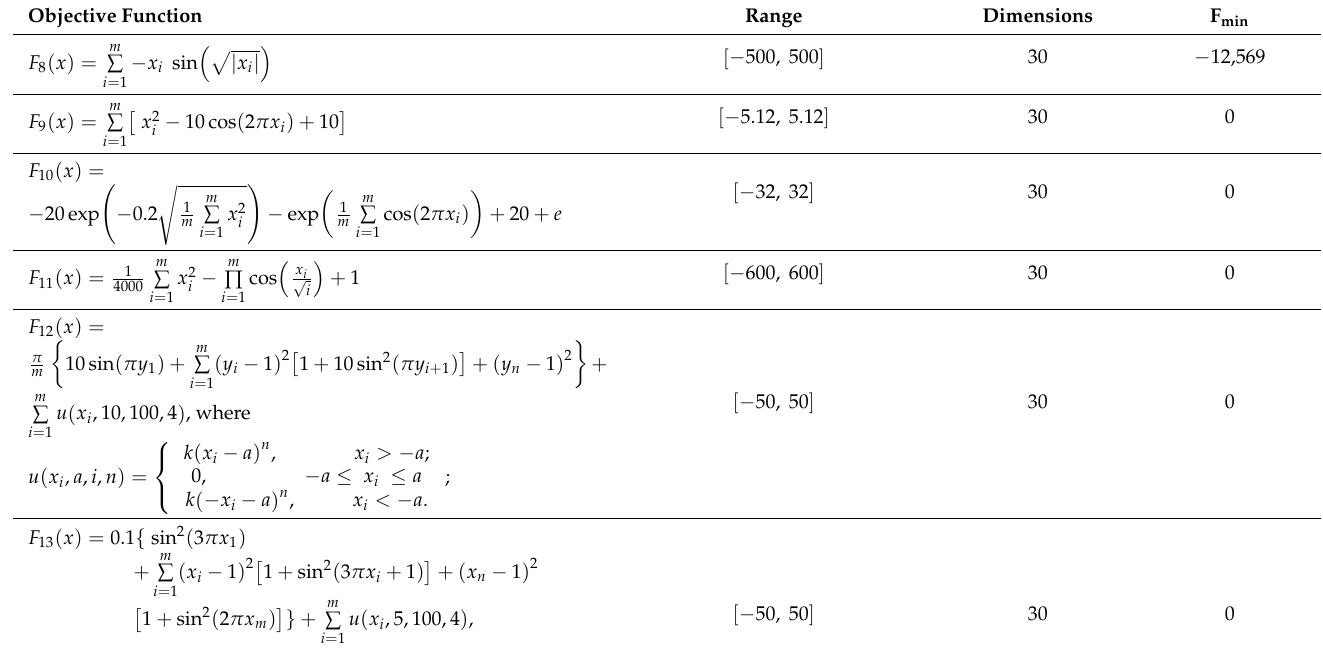
Table A2. High-dimensional multimodal